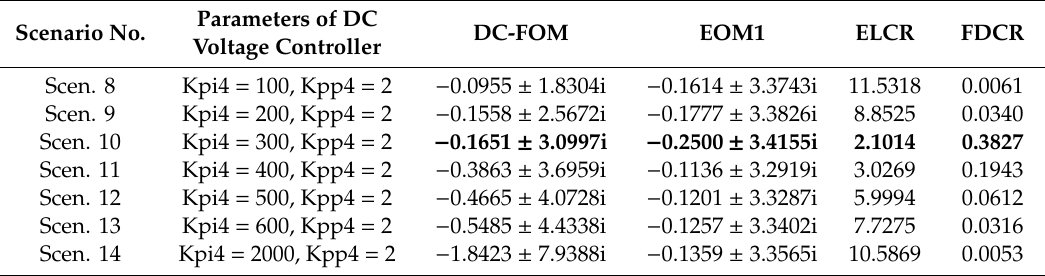
Table 3. Di ff erent scenarios with respect to DC-FOM under the 50% FCWG penetration level. Scenario